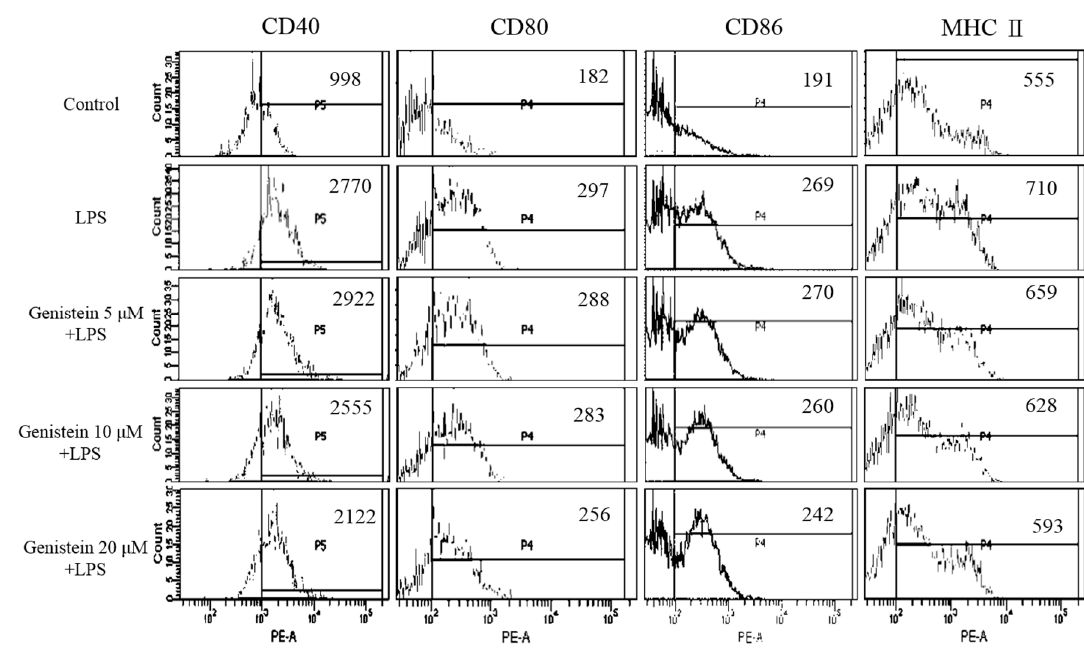
Figure 7. Genistein-mediated suppression of a maturation-associated surface marker on LPS-stimulated DCs. DCs were untreated or treated with LPS or LPS + genistein for 24 h. The suppression of major histocompatibility complex (MHC) class II and of co-stimulatory molecules (CD40, CD80, and CD86) was analyzed by flow cytometry. All of the data shown were gated on CD11c + cells. All results are representative of three independent experiments.